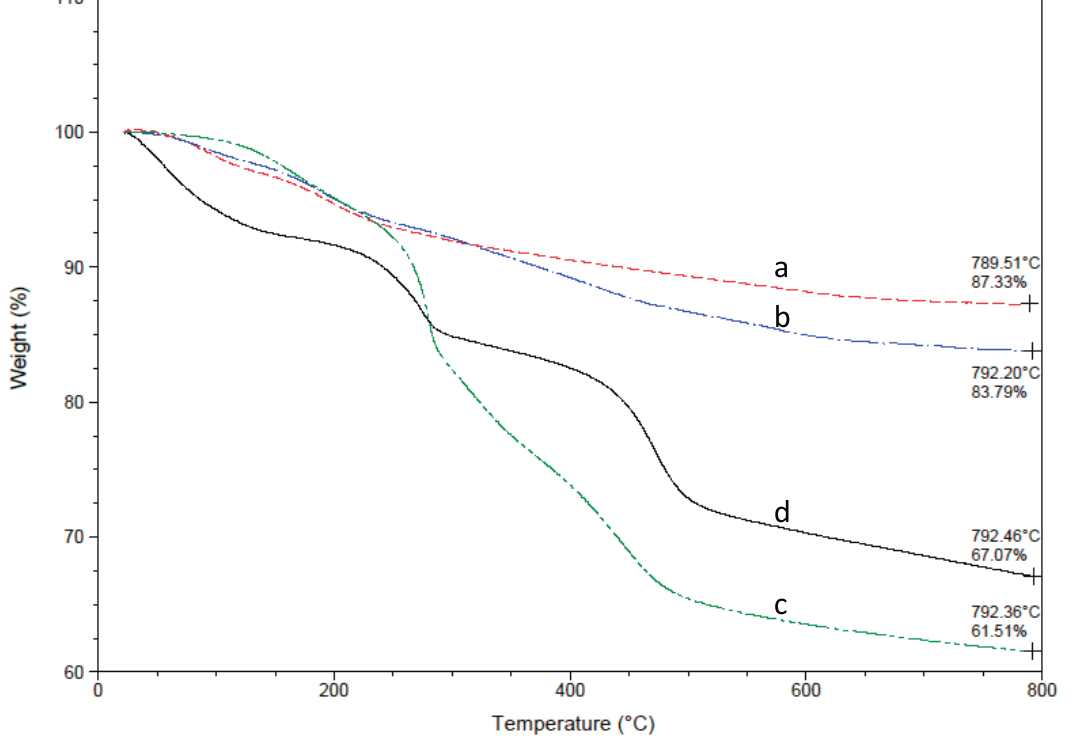
Figure 1. Thermo-gravimetric analysis (TGA) results of silica nano-particles (Si-NP) (diameter 200 nm) at various stages of decoration: ( a ) bare Si-NP; ( b ) initiator decorated Si-NP; ( c ) brush poly( t -BMA) decorated Si-NP (polymerization time 180 min.); ( d ) brush poly(methacrylic acid) (PMAA) decorated Si-NP. Note that all samples have been processed under the same conditions (freeze/drying for 5 days at 0.1 mPa at room